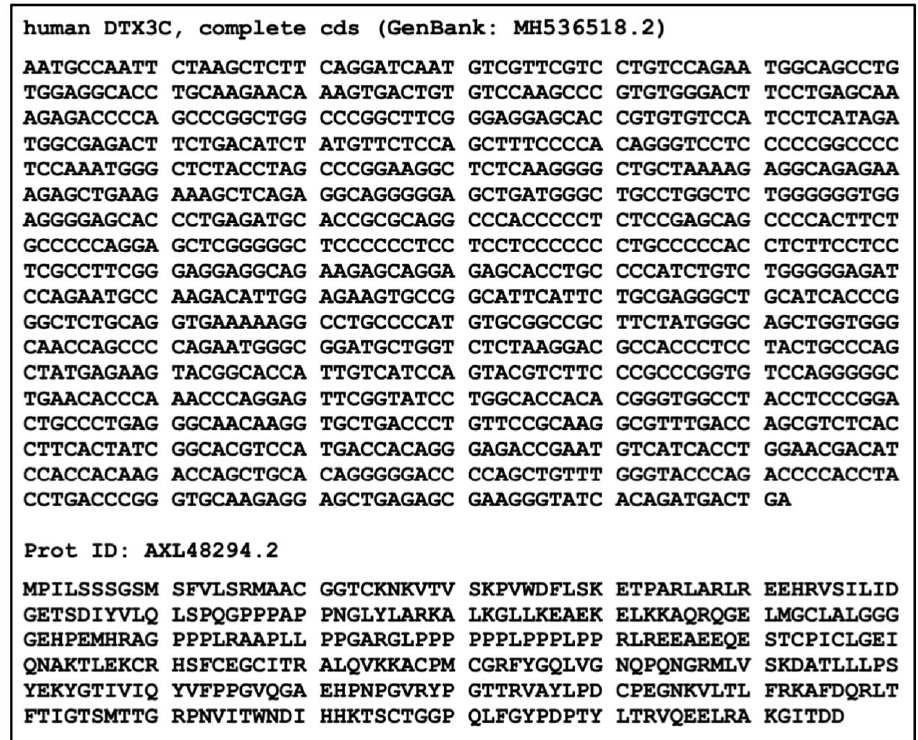
Figure 6. Full sequencing of DTX3C gene and protein translation product. In order to confirm the same sequence of DTX3c to its two isoforms on the remaining central and C-terminal region, a full CDS sequence was amplified in MSTO211H and sequenced as described in the methods. The full sequence and translated product were validated by GenBank upon submission and assigned a ref ID as indicated in the figure.